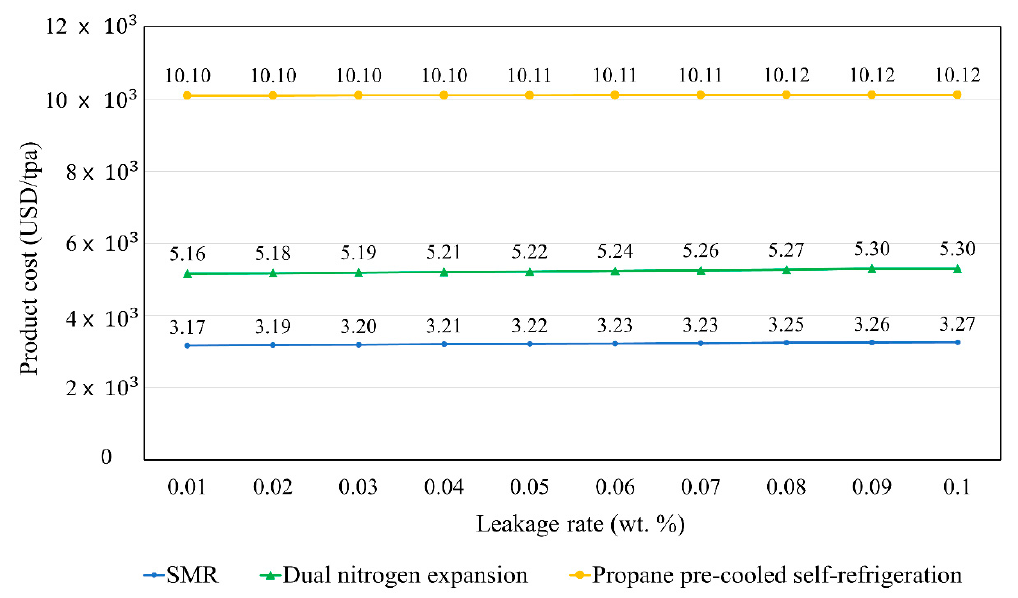
Figure 16. E ff ects of the compressor leakage on product cost of each Figure 16. Effects of the compressor leakage on product cost of each process.